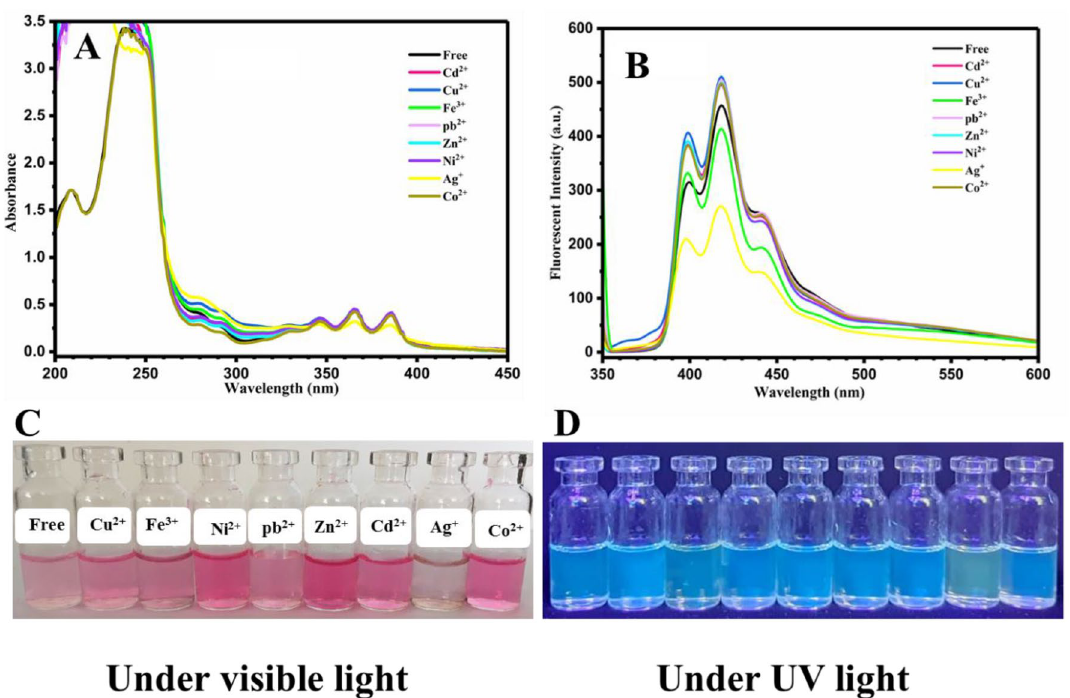
Figure 3. ( A ) UV–vis and ( B ) fluorescence spectra (excited with wavelength of 340 nm) of the OX 2 -Anthracene aqueous solutions with a concentration of 0.0002 M containing metal ions with a concentration of 0.01 M, and photographs of ( C ) color change and ( D ) fluorescence emission of the OX 2 -Anthracene/metal ions solutions under visible light and UV irradiation,